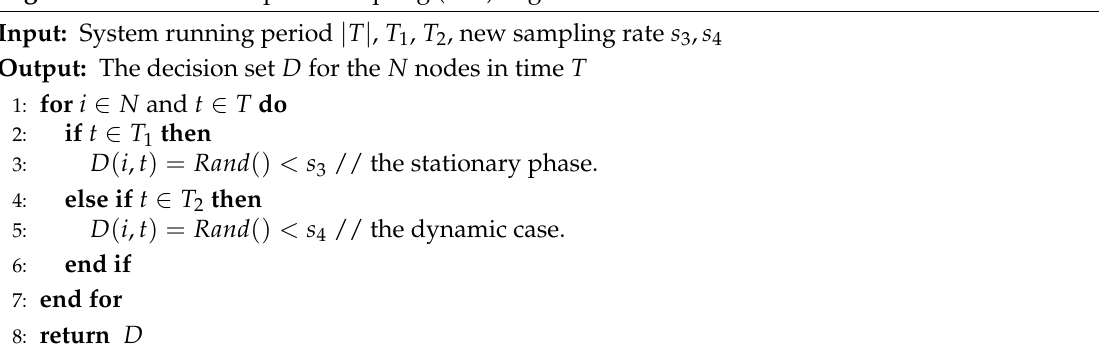
Algorithm 3 The K -Temporal sampling (K-T)